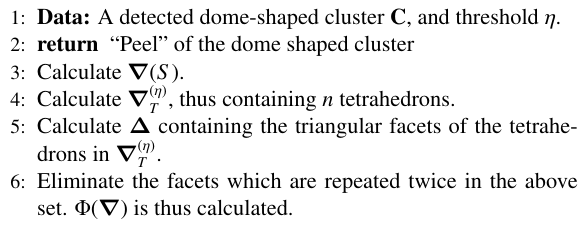
Algorithm 2 Treat dome shaped clusters